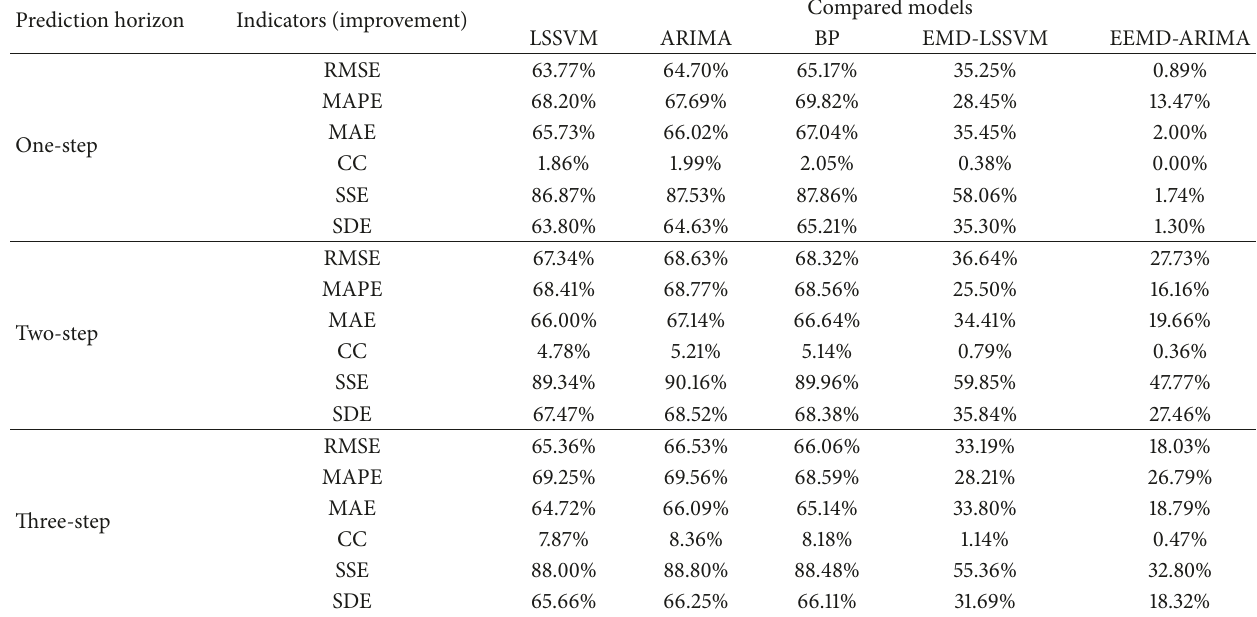
Table 7: The percentage improvements of EEMD-LSSVM over other models (Case Two).